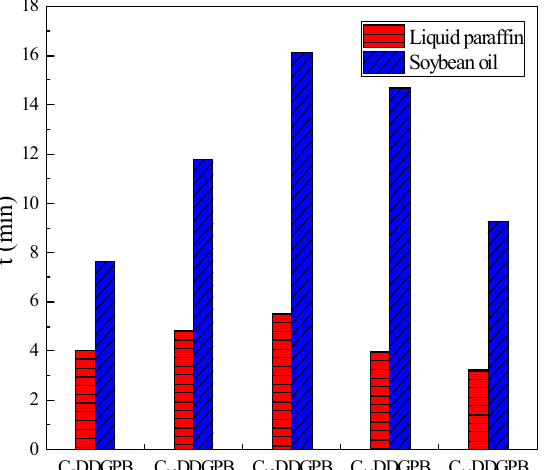
Figure 8. Emulsification performance of C n